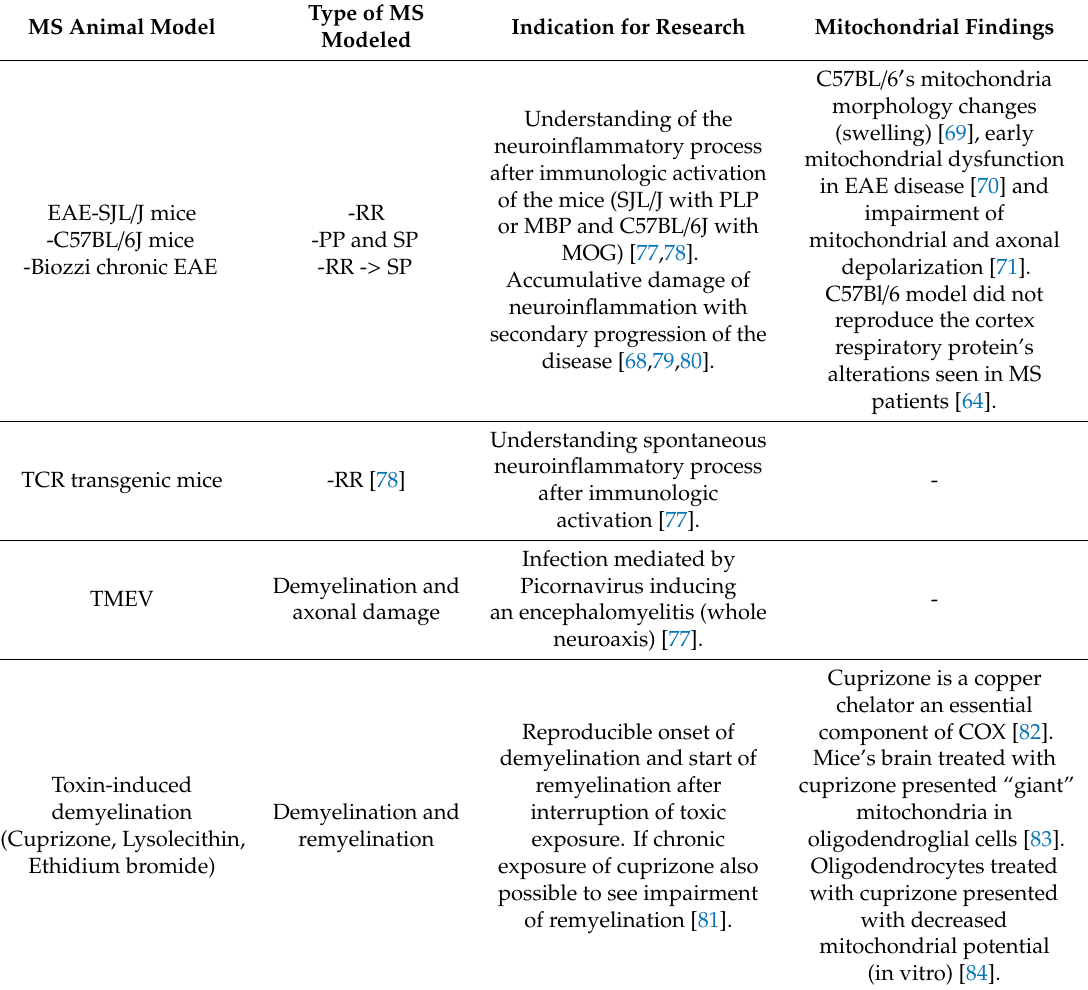
Table 2. Mouse models to study multiple sclerosis